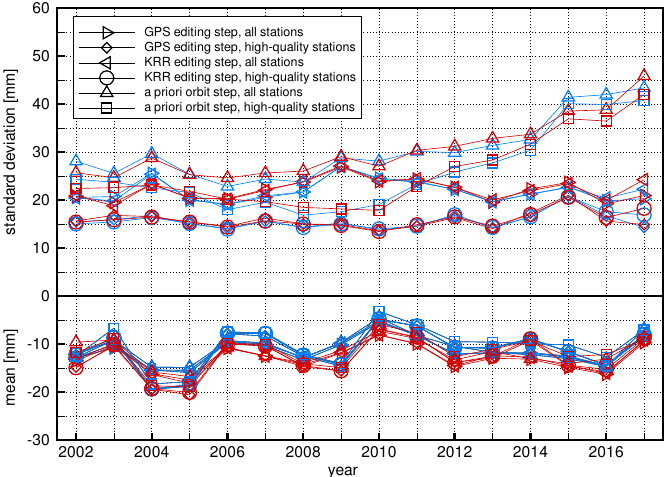
Figure 2. Mean and standard deviation per year of GRACE-A (blue) and -B (red) SLR residuals during the different GRACE processing steps for all available stations and a subset of high-quality